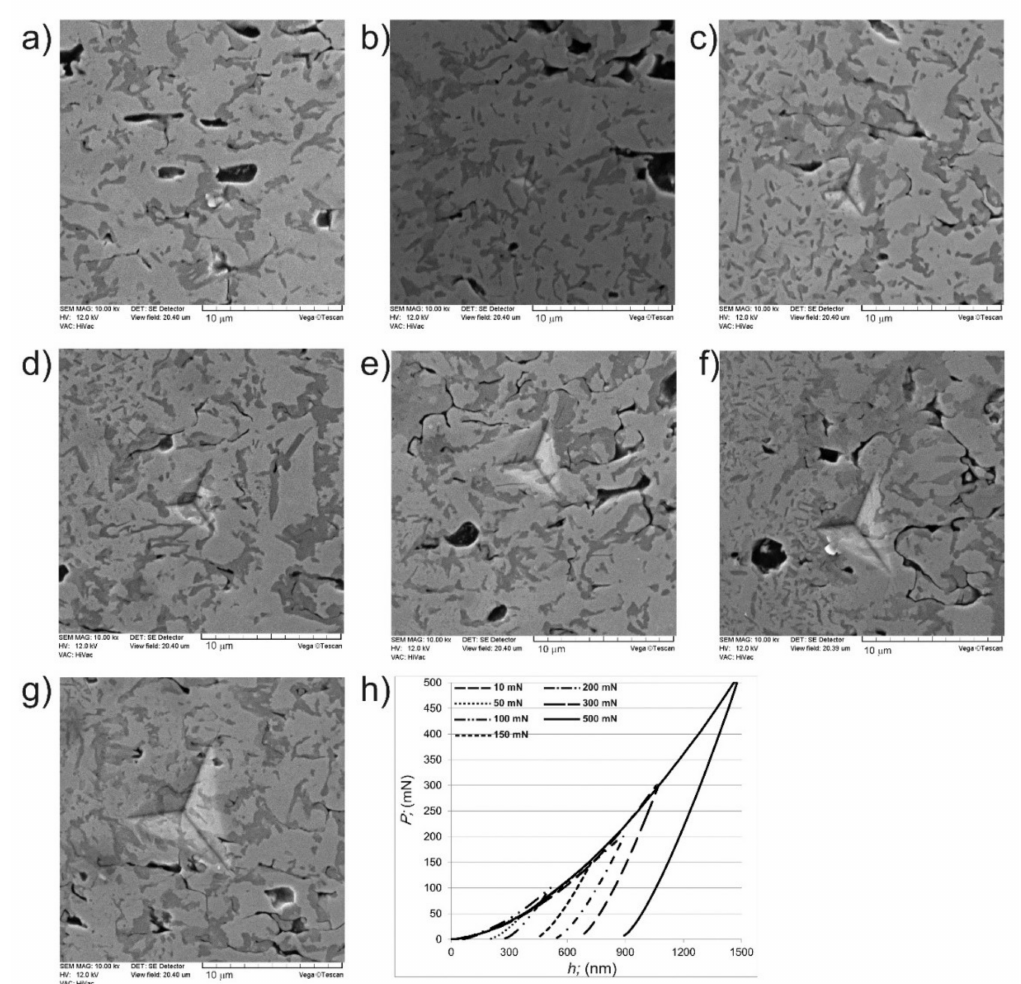
Figure 5. SEM images of areas with 20 wt.% of chromium with visible indents performed after nanoindentation under a maximum load of ( a ) 10 mN, ( b ) 50 mN, ( c ) 100 mN, ( d ) 150 mN, ( e ) 200 mN, ( f ) 300 mN, ( g ) 500 mN and ( h ) load– displacement curves recorded for areas with 20 wt.% of chromium during nanoindentation under a load range from 10 mN to 500